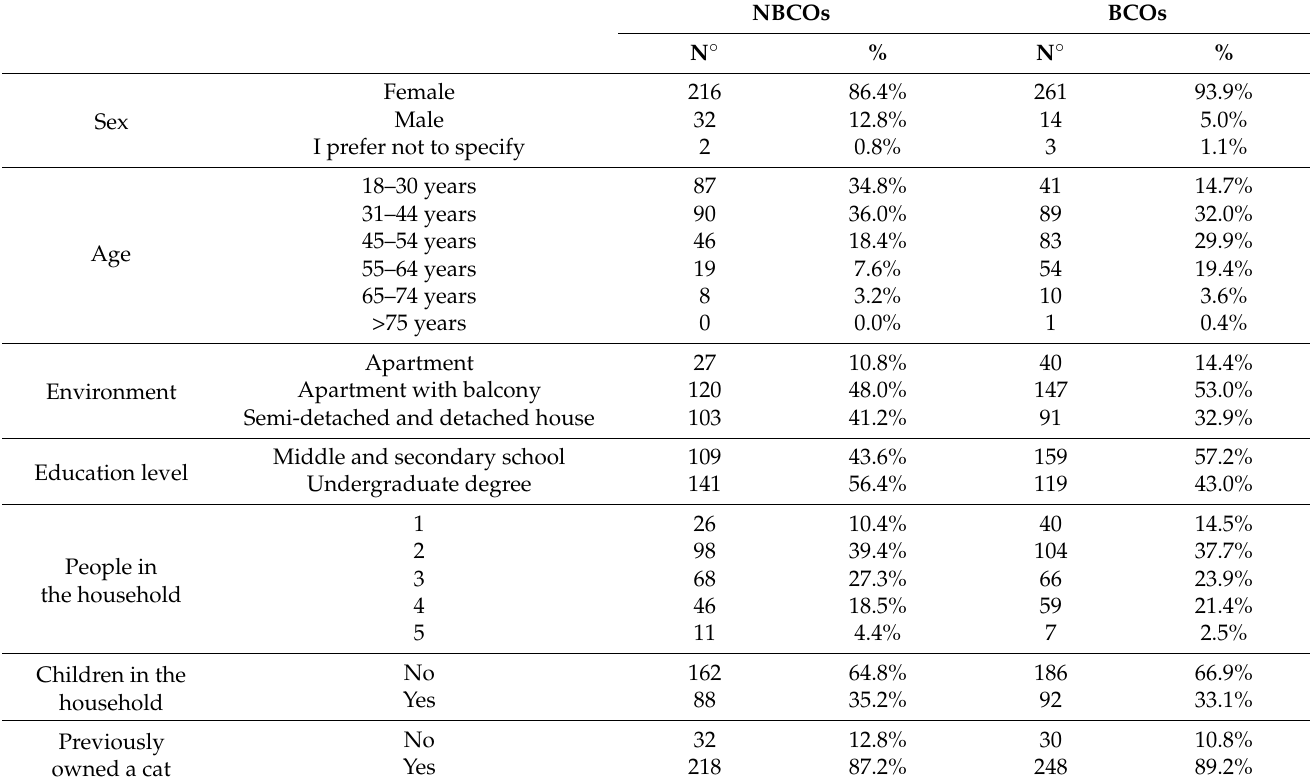
Table 1. Representation of owners’ demographic aspects by breed (NBCOs: non-brachycephalic cat owners; BCOs: brachycephalic cat